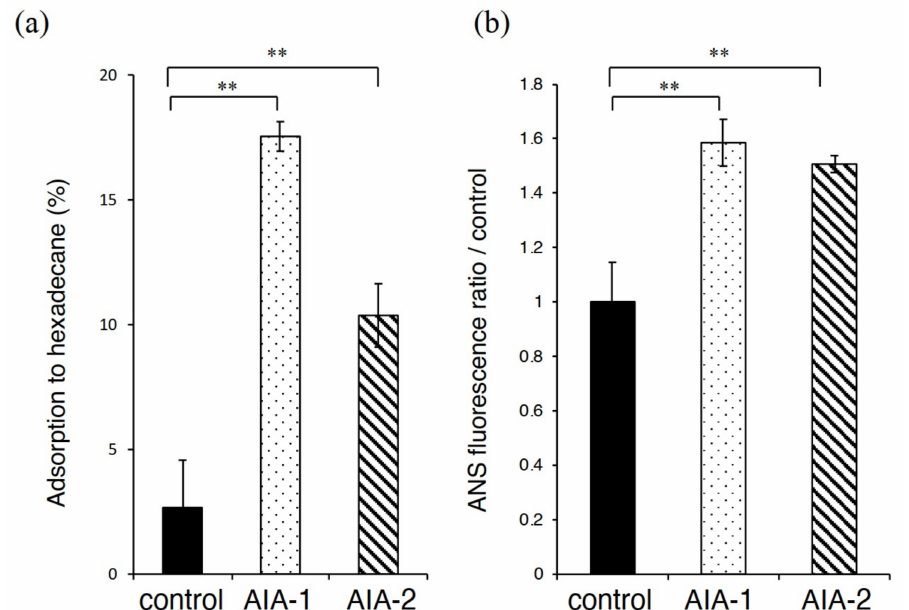
Figure 4. Hydrophobicity of PAO1 treated with AIA-1 or -2. ( a ) The rate of adsorption to hex- adecane (cell-surface hydrophobicity) ( b ) ANS (8-anilino-1-naphthylenesulfonic acid) fluorescence ratio by treatment with 32 µ g/mL AIA-1 or -2. ** p < 0.01 (Student’s t -test). Error bars, SDs for four